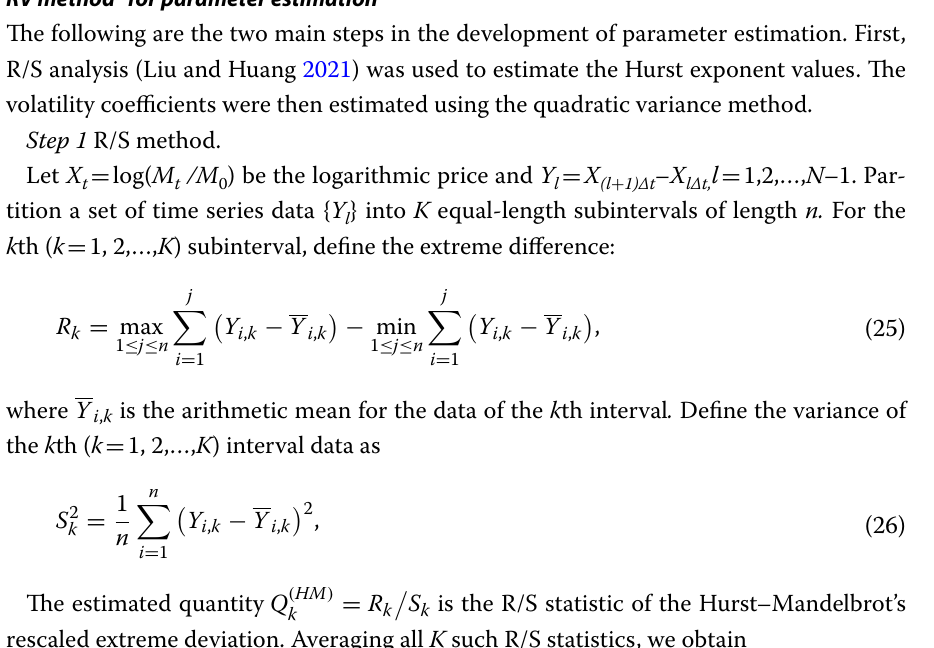
Figure 4 shows the empirical distribution in the logarithm changes,